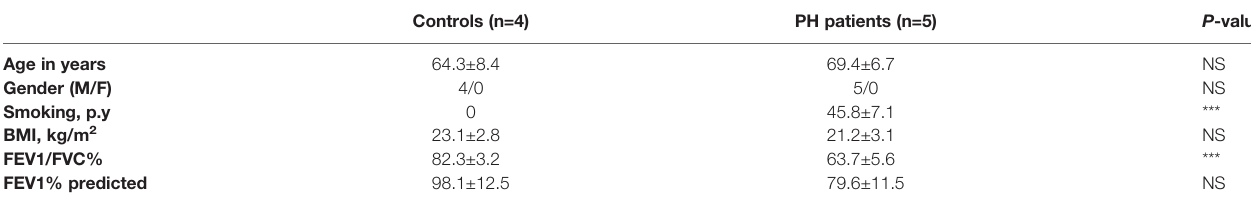
TABLE 1 | Clinical characteristics of the PH patients and the